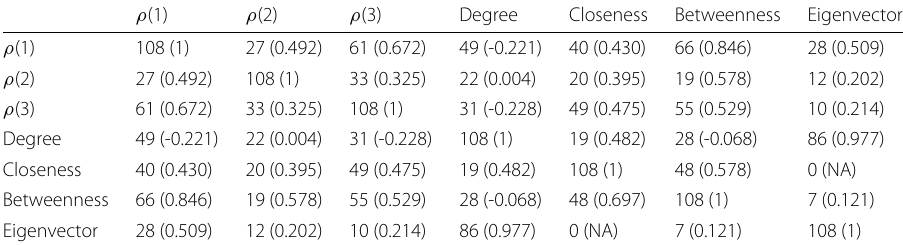
Table 3 Number of common genes among the relevance vectors of 108 genes provided by the different relevance measures ρ (1) ρ (2) ρ (3) Degree Closeness Betweenness